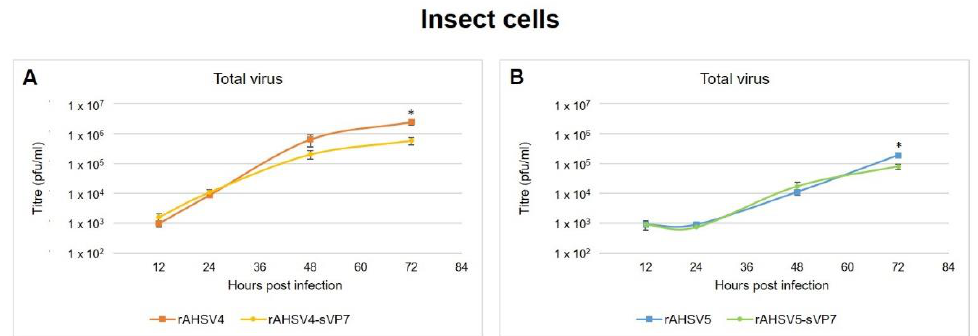
Figure 6. Replication kinetics of rAHSV and rAHSV-sVP7 viruses for attenuated serotype 4 ( A ) and virulent serotype 5 ( B ) in insect cells. Total virus yield from infected KC cells (mean titre of virus collected from media and cells) represented on a logarithmic scale. Equal amounts of KC cells were infected at a MOI of 0.1 of each virus, in triplicate, and incubated for 12, 24, 48 and 72 h. Media and cells were collected, lysed and titred as described in Section 2.7. Standard error of the mean is indicated and statistically significant differences to the wild-type virus is indicated as * ( p ≤ 0.05).